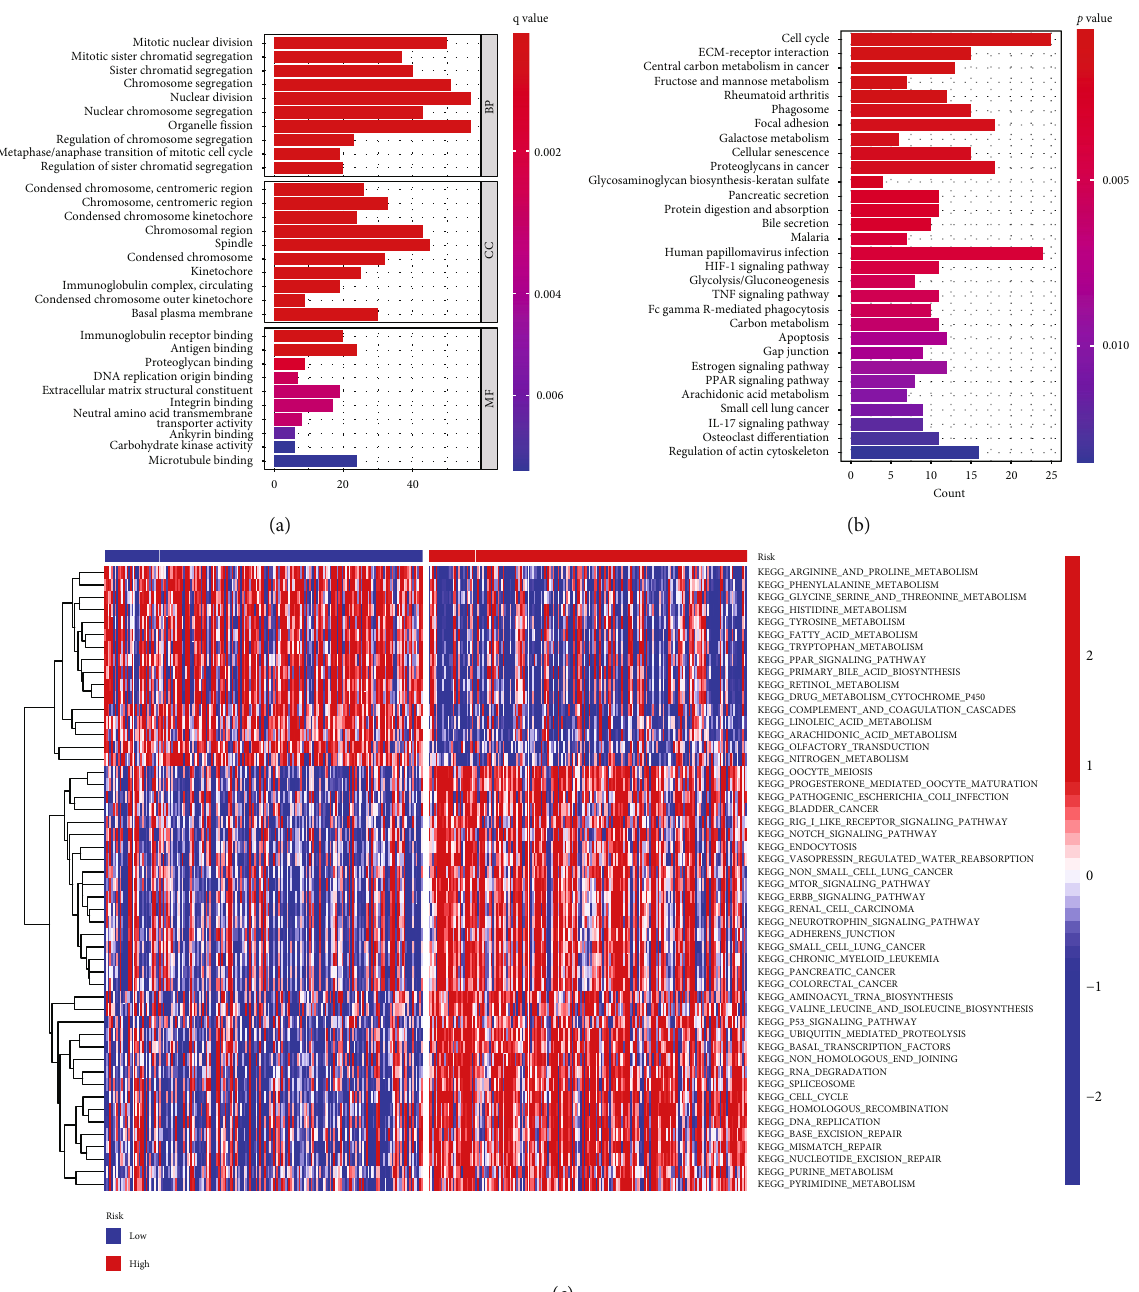
Figure 11: Functional enrichment analysis was performed according to the risk score. (a) A list of the top 10 signi fi cantly enriched GO terms. (b) A list of the top 30 most signi fi cantly enriched KEGG pathways. (c) The pathway activities scored by GSVA di ff erently for high-risk and low-risk